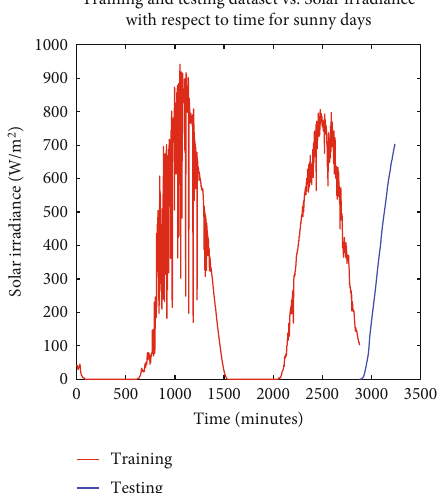
Figure 3: Cloudy day dataset training and testing